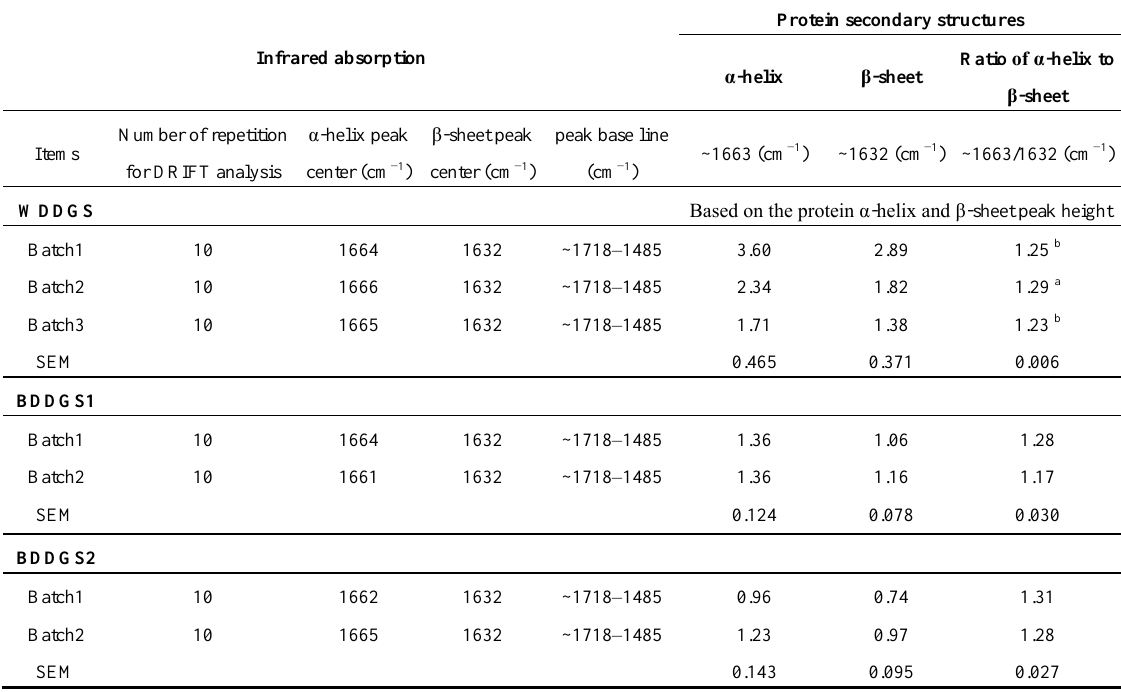
Table 4. Characteristics of protein secondary structures (α-helix, β-sheet, and their ratio): Comparison of different batches within wheat DDGS and two types of blend DDGS using DRIFT molecular spectroscopy.